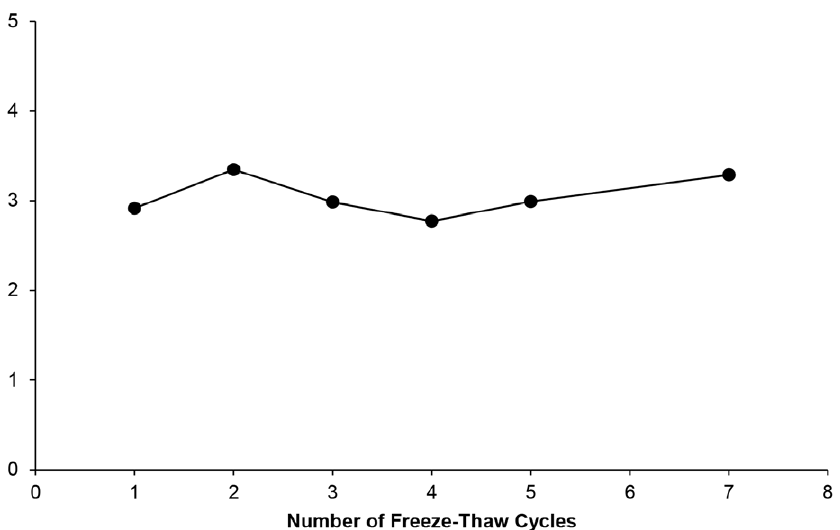
Figure 6. The effect of repeated freezing and thawing on T/S ratio measurements. DNA was extracted from whole blood aliquots obtained at each of seven consecutive freeze-thaw cycles and T/S ratios were determined.